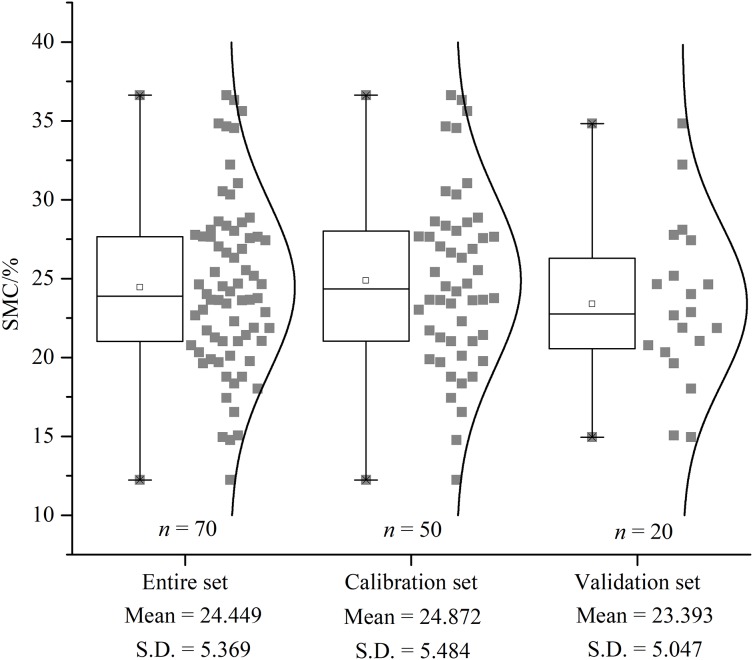
The descriptive statistical results of SMC. Box plot and distribution of SMC for the whole, calibration, and validation datasets.S.D. indicates standard deviation.